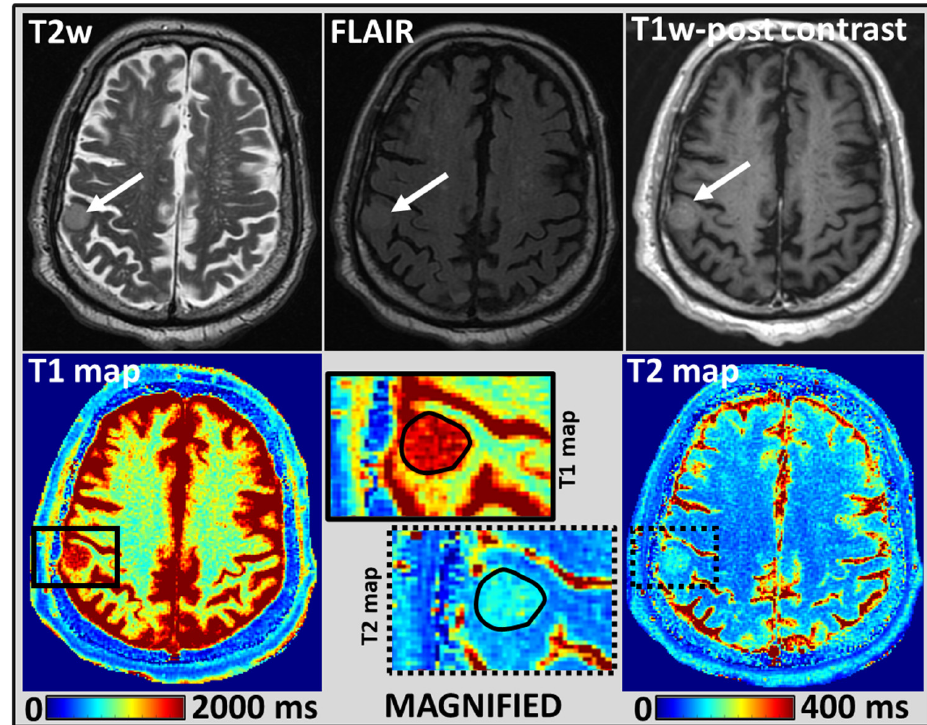
Figure 2. Representative MR images from a 72-year-old male patient with BM in the right parietal lobe treated with SRS and had a history of primary lung cancer: T2w (arrow pointing to the lesion), T2w fluid-attenuated inversion recovery (FLAIR), and T1w post-contrast images showing BM lesion at right parietal lobe ( top row ). MRF-derived quantitative T1 and T2 maps ( bottom row ). A black solid and dotted rectangle region on T1 and T2 maps, respectively, were magnified, and the placement of a manually drawn ROI for the BM lesion was shown in a solid black line. The MRF-derived T1 and T2 values at the BM lesion were 2355 ms and 154 ms, respectively.